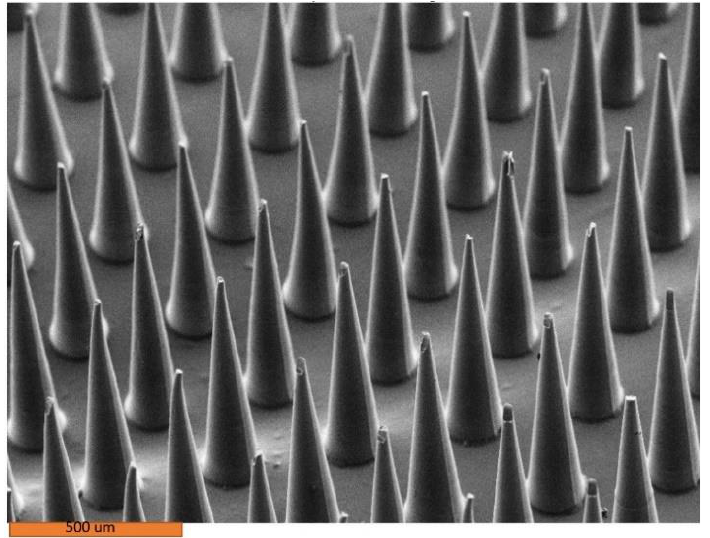
Figure 3. Scanning electron microscope image of 4% amphotericin B –Gantrez™ microneedles.